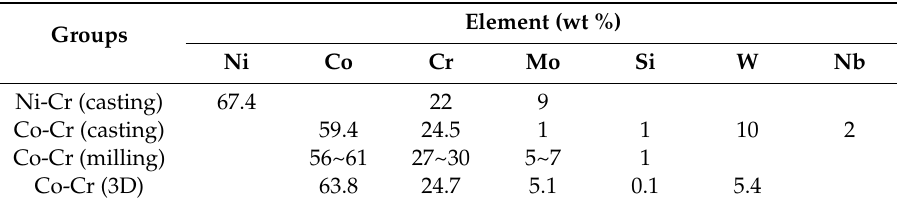
Table 1. Compositions of the Co-Cr and Ni-Cr